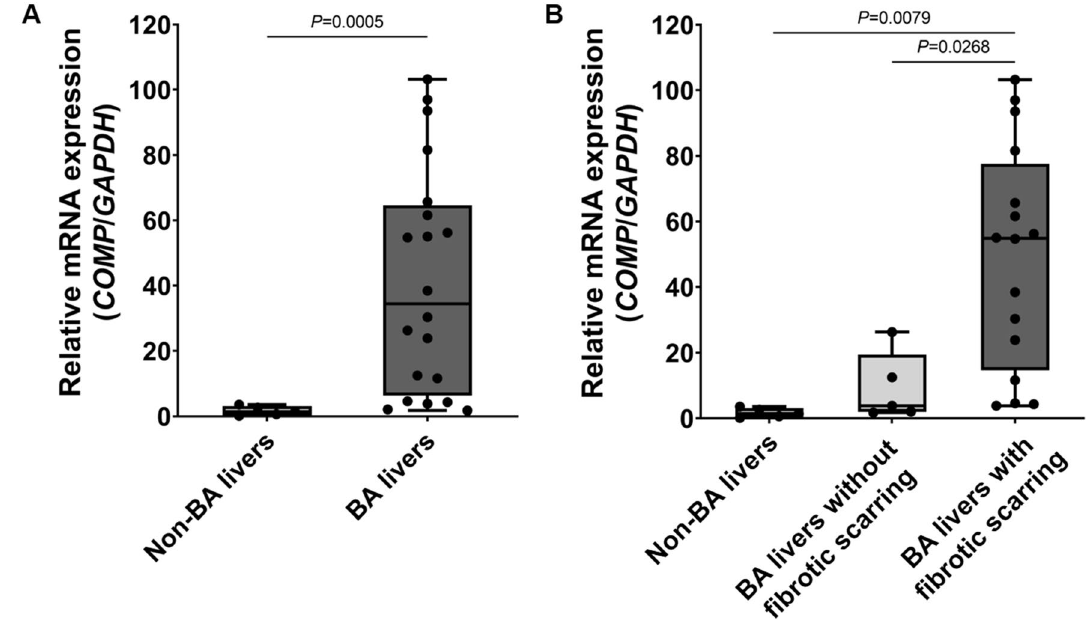
Figure 3. Relative COMP mRNA expression in non-BA livers and BA livers with and without the fibrotic scarring. ( A ) Non-BA livers ( n = 5) and BA livers ( n = 20). ( B ) BA livers without fibrotic scarring ( n = 5) and with fibrotic scarring ( n =